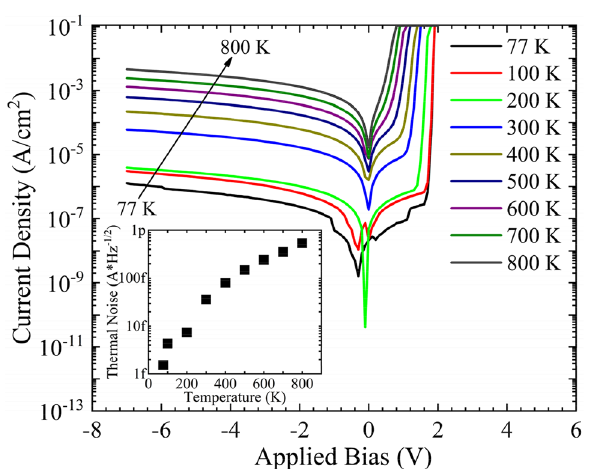
Figure 5. I–V characteristics of the AlGaAs/GaAs DH for temperatures from 77 to 800 K. Inset shows the evolution of thermal